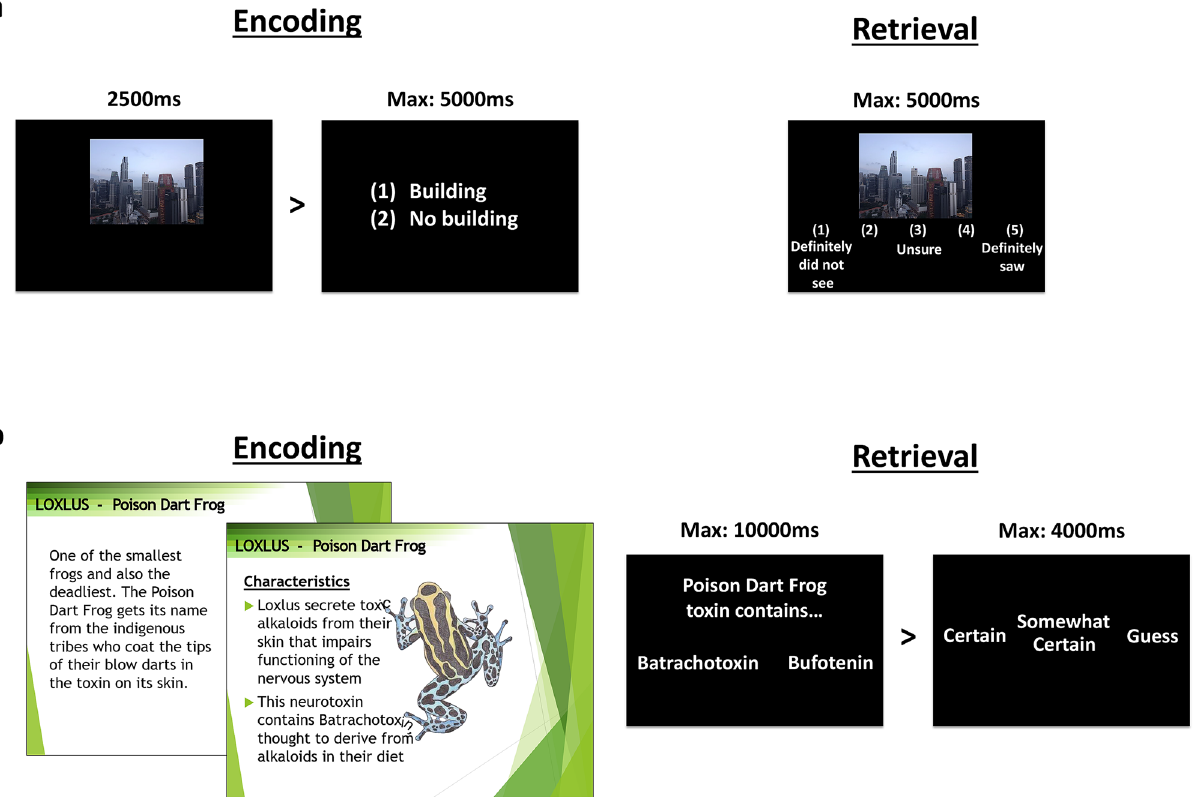
Figure 2. Stimuli. ( a ) For picture encoding, participants were not aware that it was a memory task and simply viewed 160 pictures, each followed by a building/no-building judgment. All 160 old images were presented again during retrieval, randomly intermixed with 80 new images. Participants were required to indicate their confidence that images were old or new on a 5-point scale. ( b ) Factual knowledge encoding involved slides with detailed information and pictures about 12 species of amphibians. Each encoding session included six species and lasted 1 h. Participants were encouraged to take notes to help them learn. Retrieval consisted of 2-alternative forced choice questions of varying difficulty (360 questions in total) followed by a confidence